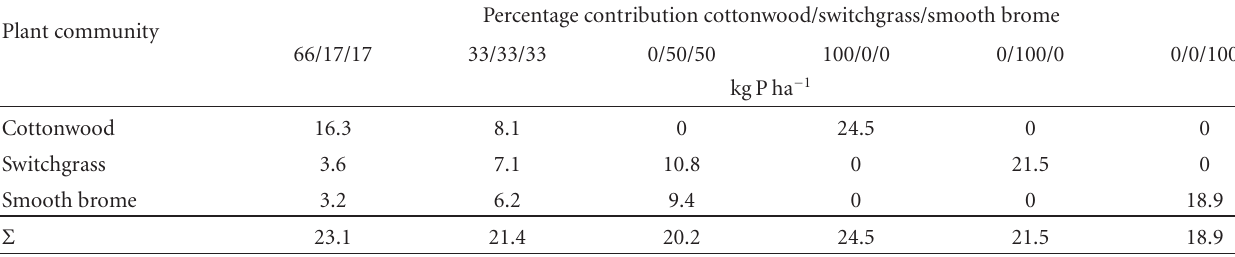
Table 4: NST 3.0 model estimates of phosphorus uptake in kilograms per hectare to a depth of 120 cm over a 126 d growing season for bu ff ers composed of varying percentages on an area basis of cottonwood, switchgrass, and smooth brome. Plant community